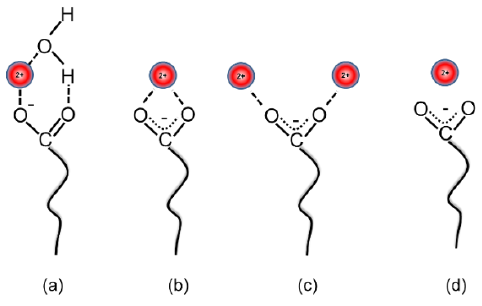
Figure 6. Bonding modes identified for divalent ion interactions with carboxylates [47,84–86]. 1:1 coordination is shown in binding modes ( a ) and ( b ), with bridging exhibited in ( c ). ( d ) shows ionic bonding.